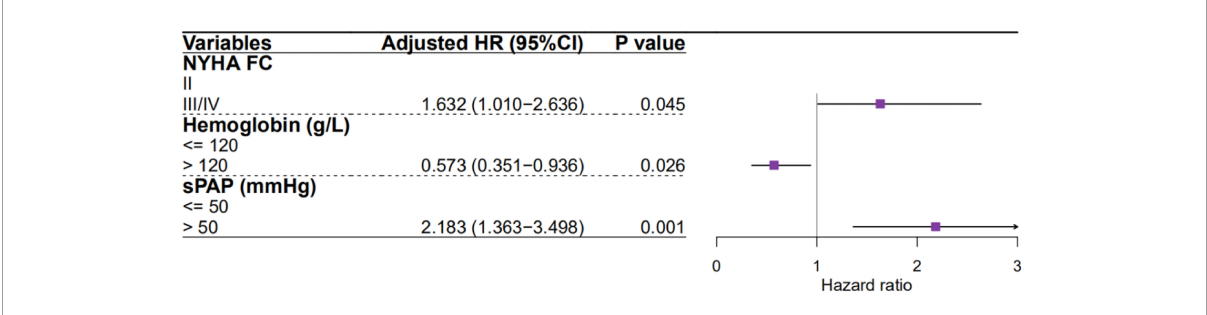
FIGURE5 Predictors of mortality for PH-LHF patients in multivariate Cox proportional hazards regression